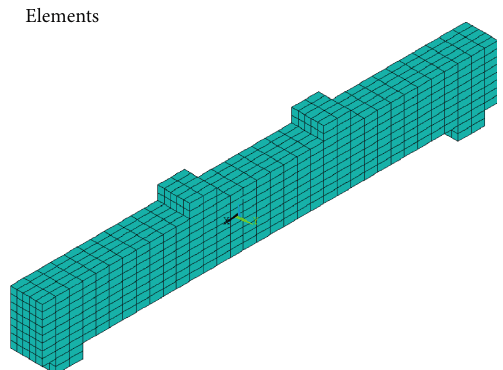
Figure 10: Finite element model of corroded reinforced concrete